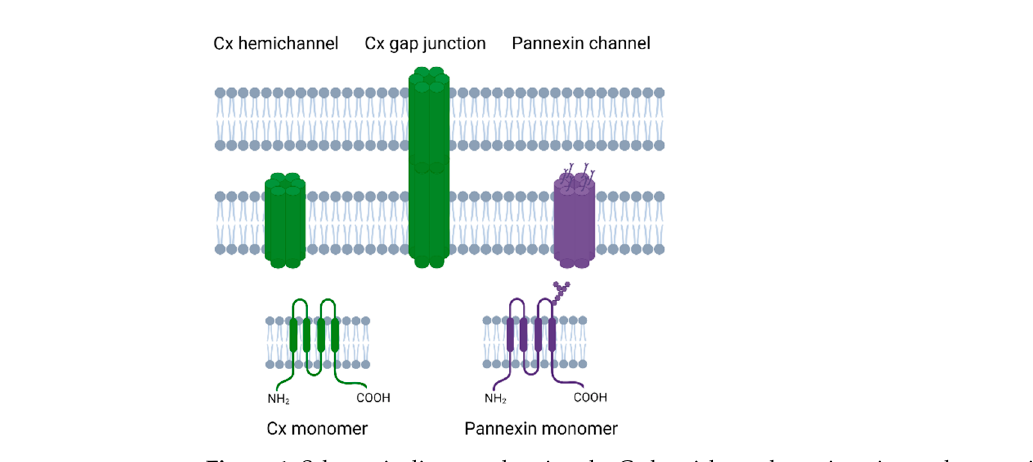
Figure 1. Schematic diagram showing the Cx hemichannel, gap junction and pannexin channels with the Cx and pannexin monomers. Cx hemichannels and pannexin channels can link the intracellular to extracellular environments whereas Cx gap junctions can link two adjacent cells.